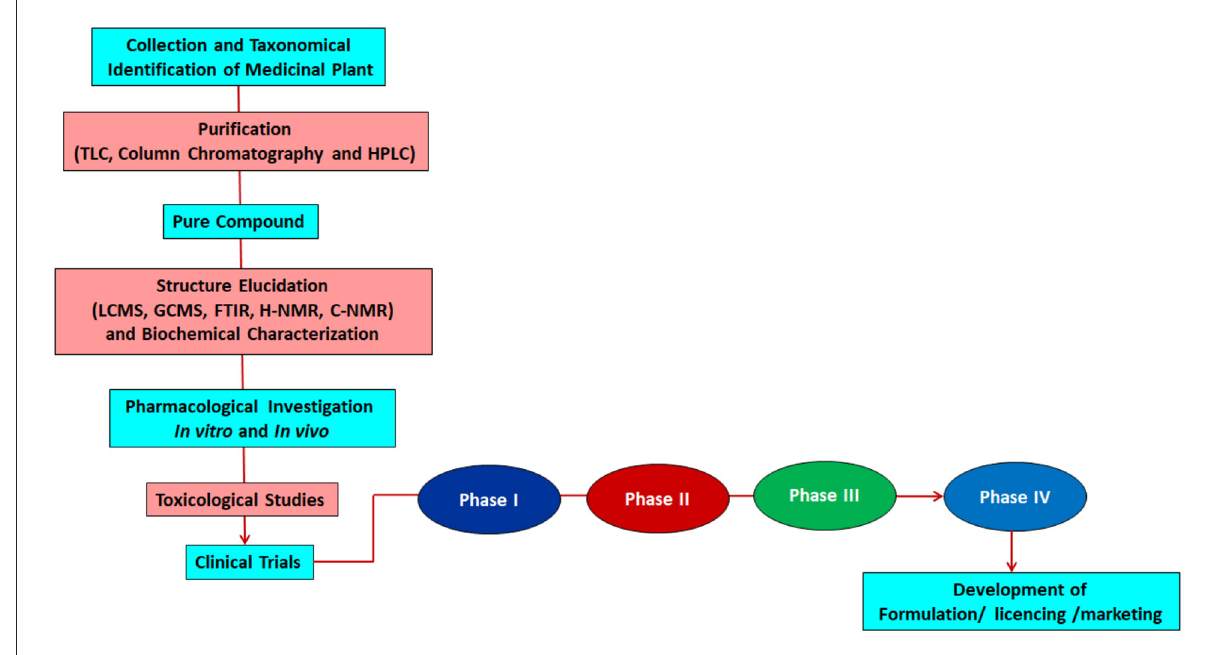
FIGURE4 The Global concept of standardization, quality evaluation and pharmacological validation for the development of herbal